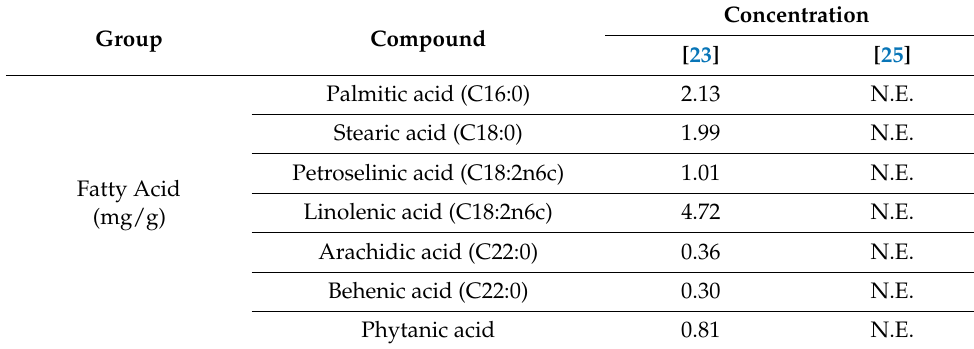
Table 2. Hydrophobic compounds composition of C. ternatea